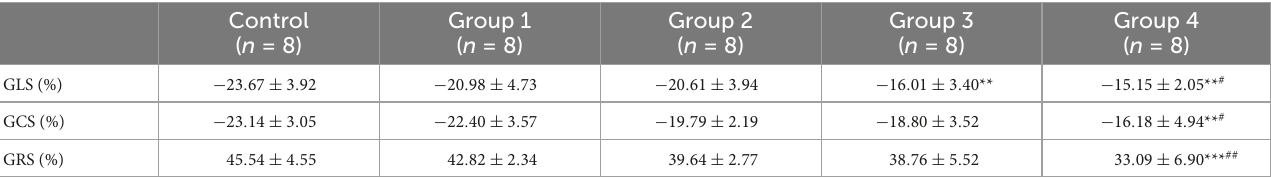
TABLE 2 2D-Speckle tracking data of all groups.